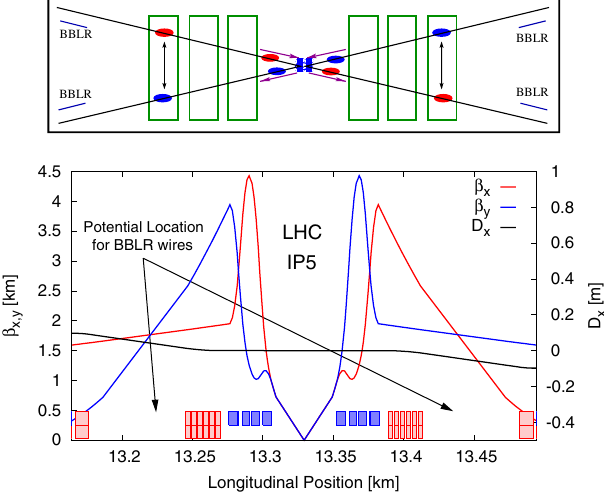
FIG. 2. LHC interaction region schematically showing the common focusing channel with the 32 long-range interactions on the left and the right of the collision point (top) and the optics functions in the region.